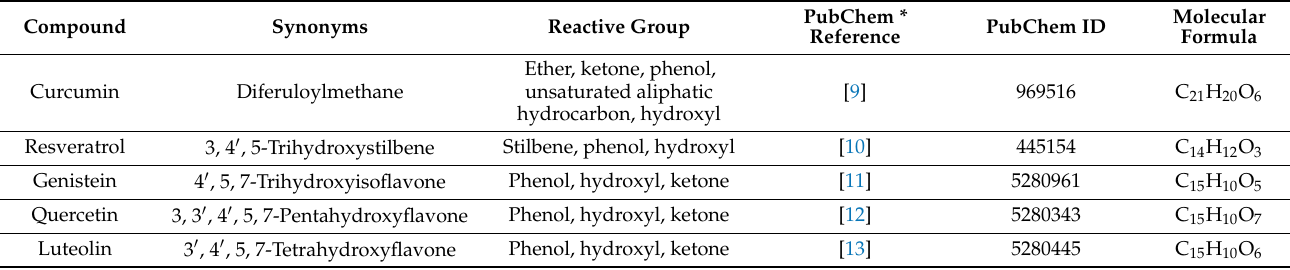
Ether, ketone, phenol, unsaturated